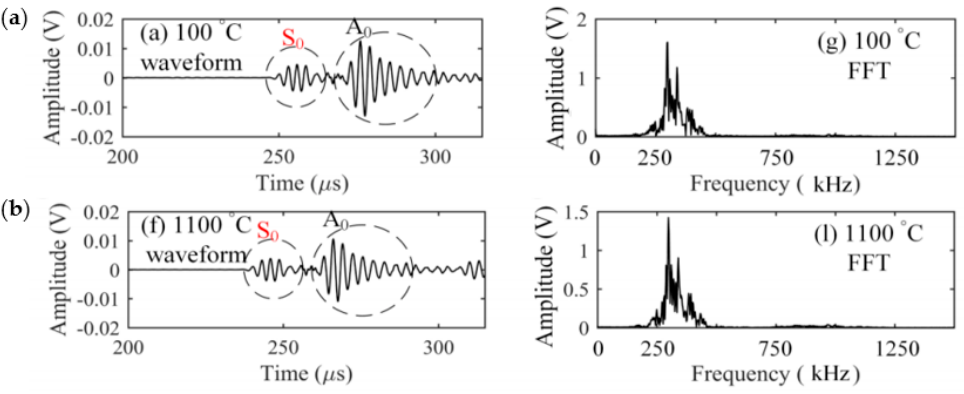
Figure 11. A demonstration of the response of a high temperature FBG sensor to an ultrasonic wave of central frequency 300 kHz, at: ( a ) 100 °C and; ( b ) 1100 °C [46].